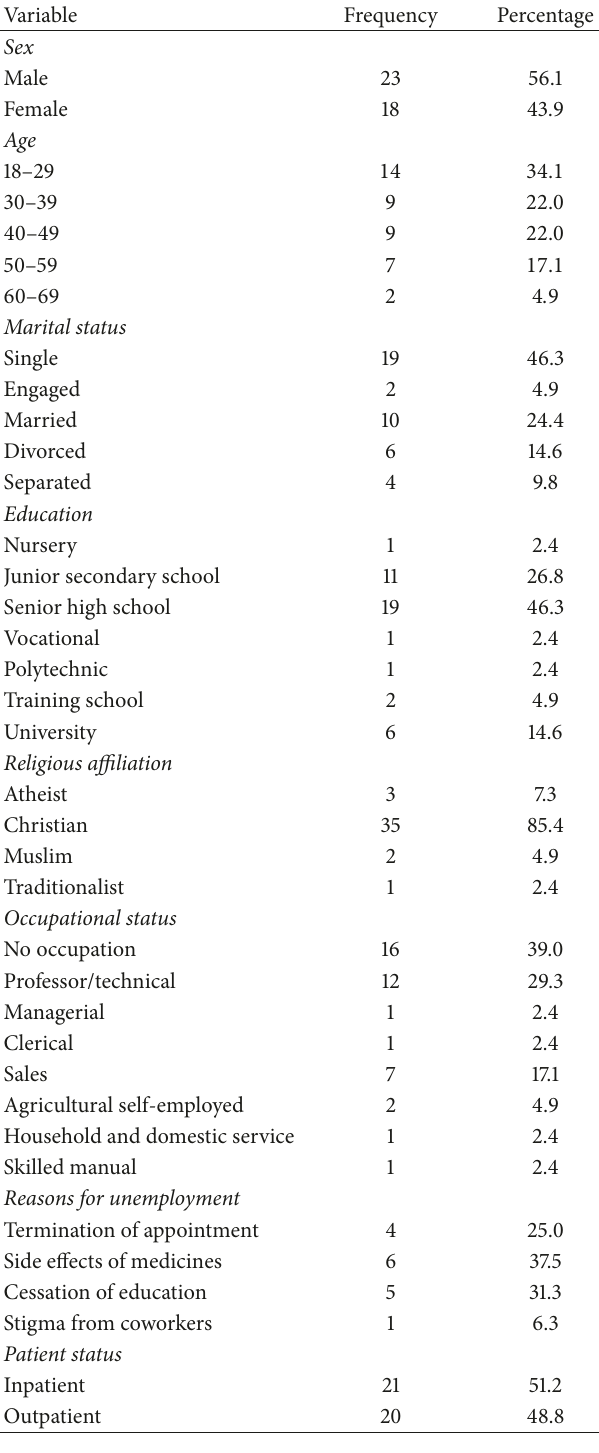
Table 2: Sociodemographic data of study participants who per- formed below the cut-off for the